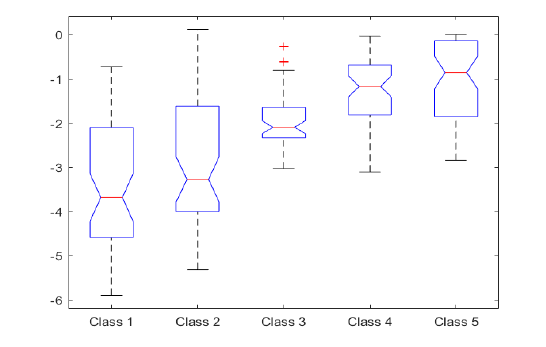
Figure 10. Boxplot of Value at Risk in Five Different